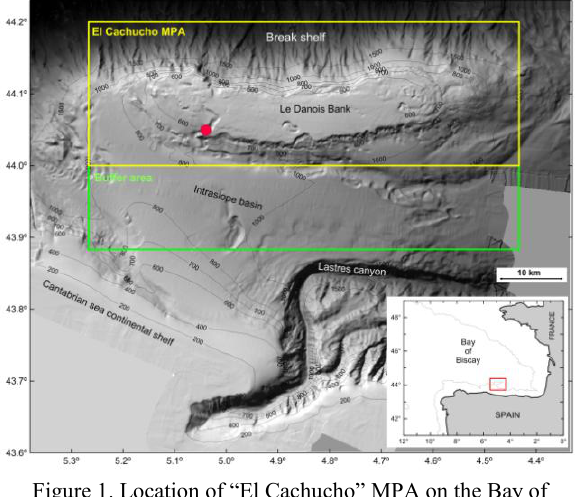
Figure 1. Location of “El Cachucho” MPA on the Bay of Biscay and some topographic features that characterize the area. The red circle shows the location of the gorgonian forest analysed on this study.